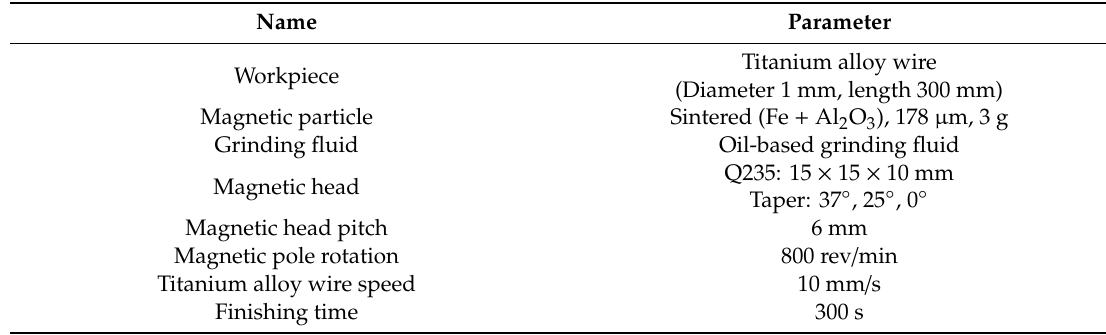
Table 1. Experimental condition.